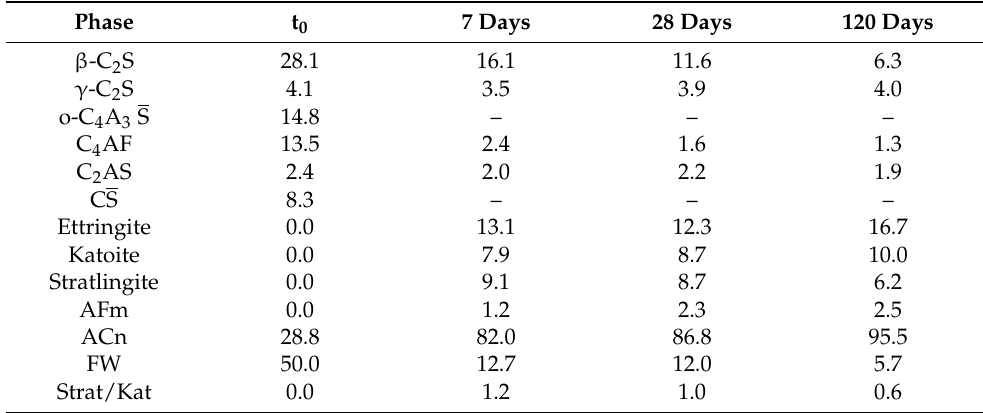
Table 4. RQPA, including ACn and FW of st-BYF with w/c = 0.50 (st-BYF-wc050), per 100 g of anhydrous cement. Stratlingite/katoite ratio is also